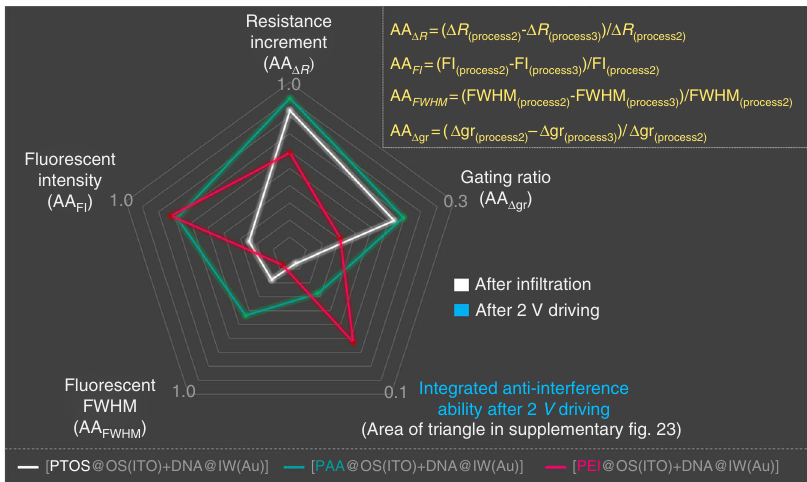
Fig. 7 The radar map re fl ecting the anti-interference performance of FE OS . The radar map integrates the fi ve parameters re fl ecting the variation by the interference of cpDNA-Cy5 or AIEgens after in fi ltration and after 2 V driving. The fi ve parameters are considered as the resistance increment from step 1 (or step 2) to step i (AA Δ R ), gating ratio (AA gr ), fl uorescent intensity (AA FI ), fl uorescent FWHM (AA FWHM ). The calculated formulas are listed as AA Δ R = ( Δ R (process 2) − Δ R (process 3) )/ Δ R (process 2) , AA FI = (FI (process 2) − FI (process 3) )/FI (process 2) , AA FWHM = (FWHM (process 2) − FWHM (process 3) )/ FWHM (process 2) , AA Δ gr = ( Δ gr (process 2) − Δ gr (process 3) )/ Δ gr (process 2) (where the Δ gr were calculated by taking R B as 100%). The fi fth parameter is the area of triangle in Supplementary Fig. 23 to value the integrated anti-interference ability after 2 V driving. The bigger area of the polygon, the greater anti- interference of